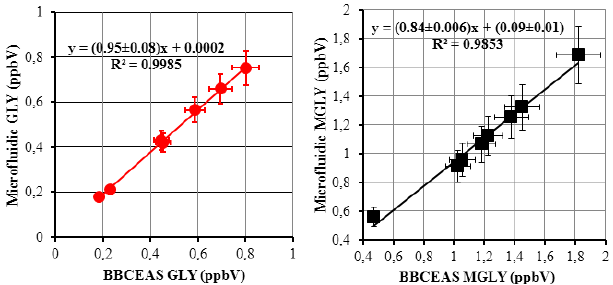
Fig. 6. Intercomparison of microfluidic derivatisation technique and BBCEAS for GLY and MGLY near detection limits. (a) : linear rela- tionship for GLY measurement (error bars for two techniques indi- cate the uncertainties); (b) : linear relationship for MGLY measure- ment. The uncertainties of the slopes are less than